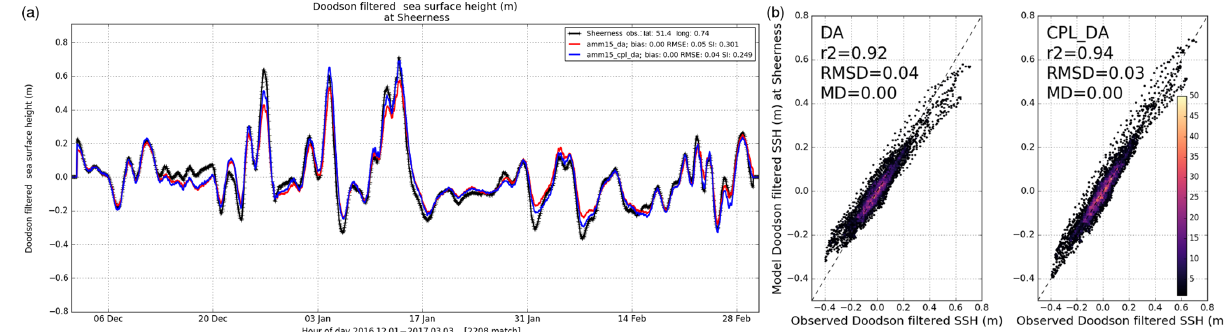
Figure 15. (a) Time series of Doodson-filtered SSH for observations and simulation at Sheerness tidal buoy during winter 2016/2017. (b) Scatter plots comparing hourly simulated filtered SSH during all of 2017 from DA and CPL_DA simulations with observed values at Sheerness (marked “Sh” in Fig. 3a). Summary r 2 correlation coefficient, RMSD and MD (Model minus Observation) statistics are listed for each model run. Shading reflects the number of points within data bins.